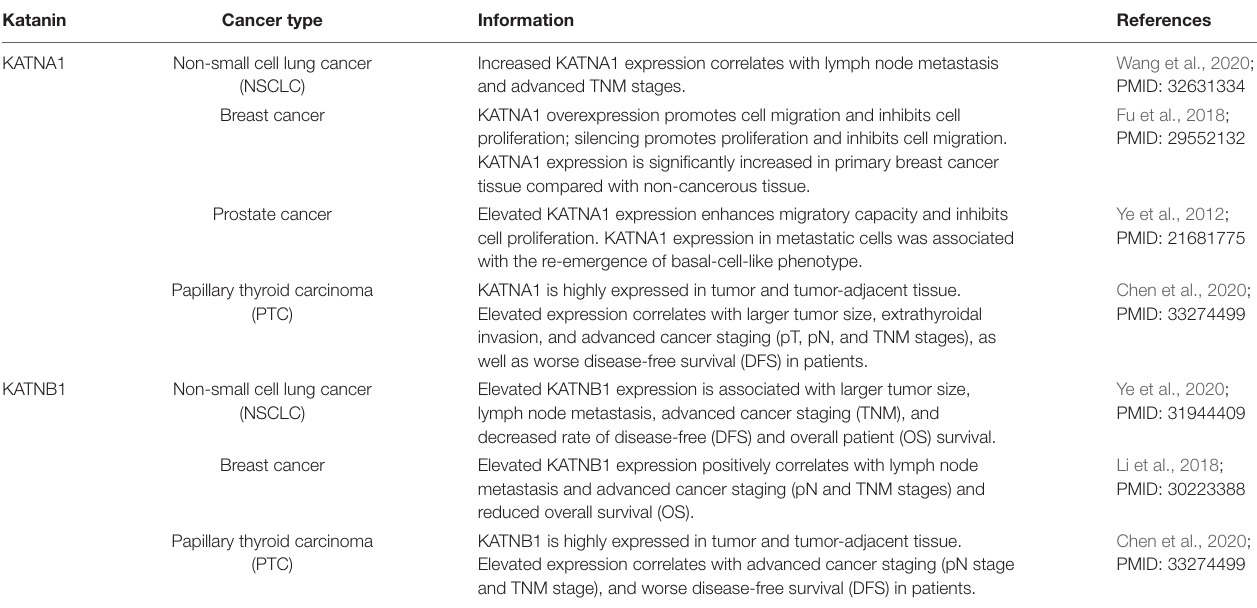
TABLE 1 | Katanin involvement in cancer